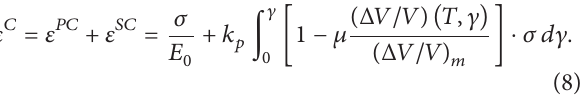
graphite. The failure probability increases from 0 to 100% when the stress rises from 10 MPa to 20 MPa. The stress corresponding to 50% failure probability, ∼ 16 MPa, is always defined as the mean strength